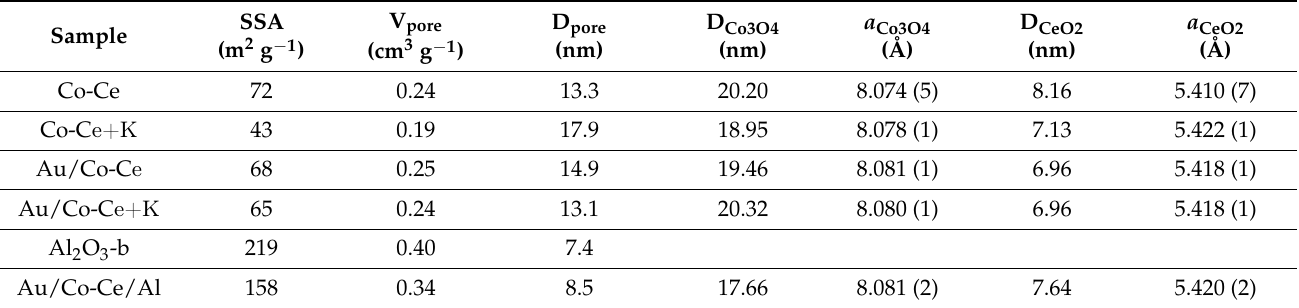
Table 1. Specific surface area (SSA), pore volume (V pore ), and average pore diameter (D pore ) of the studied samples; average size and lattice parameter of Co 3 O 4 (D Co3O4 and a Co3O4 ) and ceria (D CeO2 and a CeO2 ) evaluated by XRD.